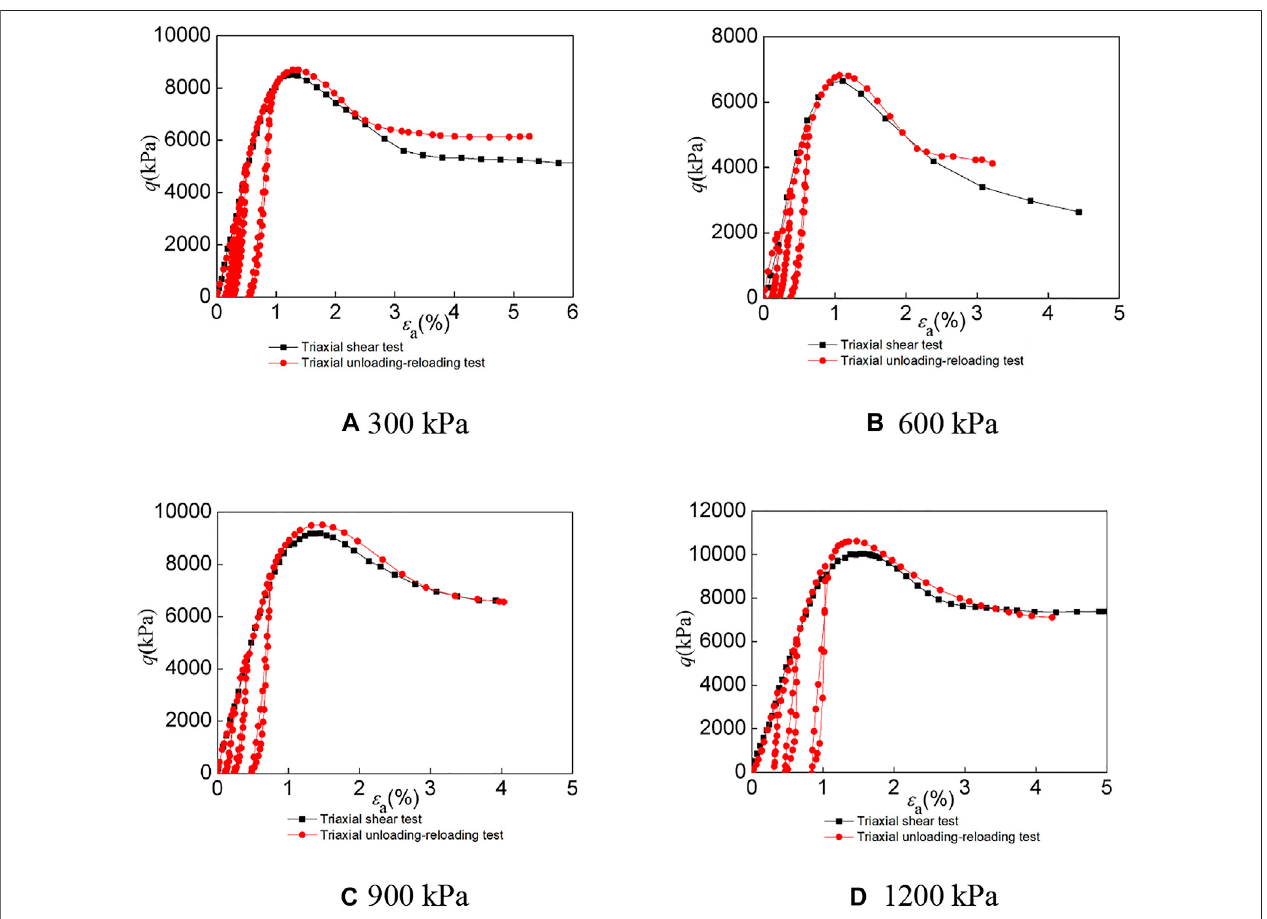
FIGURE4| Stress – straincurves ofLCSGmaterial withcementedcontentof100 kg/m 3 underdifferentcon fi ningpressures. (A) 300 kPa (B) 600 kPa (C) 900 kPa (D) 1,200 kPa.